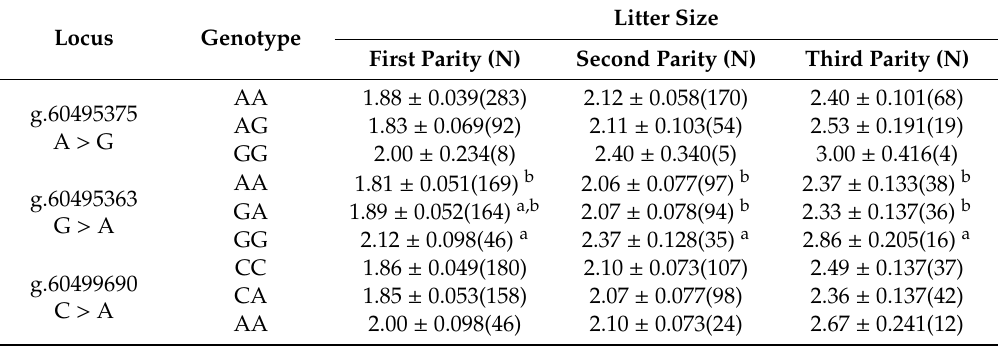
Table 4. Least squares mean and standard error of litter size in Small Tail Han sheep with di ff erent